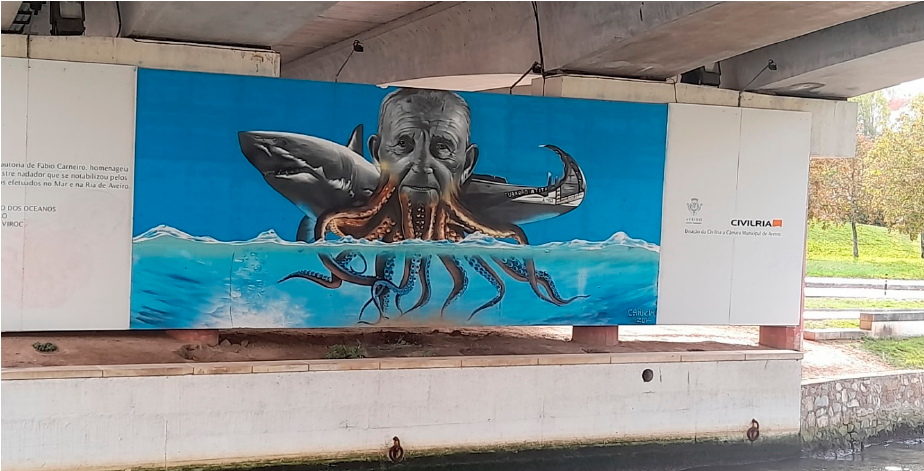
Figure 7. Tribute to Atita, by Fábio Carneiro, 2014 (Source: author’s own photos, 2022)